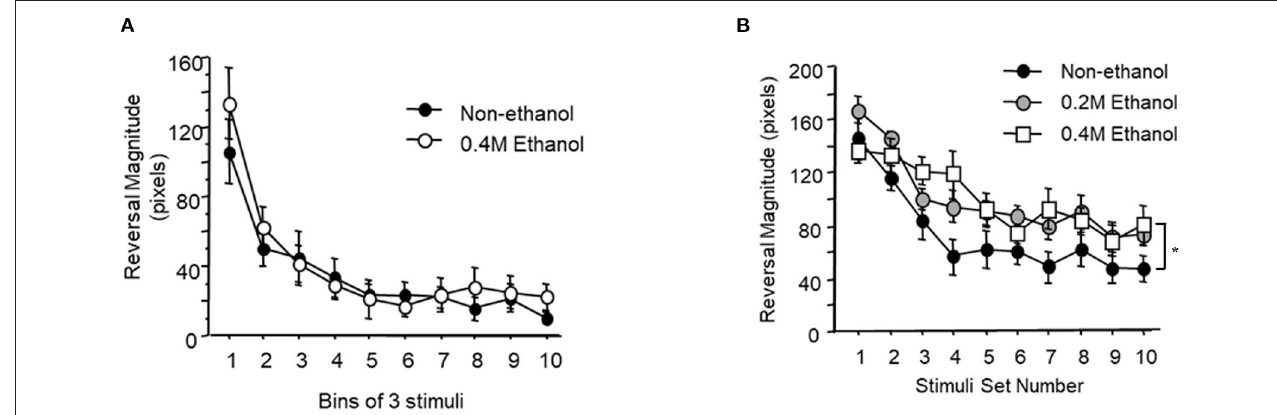
FIGURE 2 | Short-term habituation during ethanol exposure. (A) Mean reversal magnitude ( ± SEM) to 30 tap stimuli delivered at a 10s interstimulus interval and averaged in bins of three stimuli for control (black circle) vs. worms exposed to 0.4M ethanol (white circle). (B) Mean reversal magnitude ( ± SEM) to 30 tap stimuli delivered at a 60s ISI averaged in bins of three stimuli for control (black circle), 0.2M ethanol exposed worms (gray circle) and 0.4M ethanol exposed worms (white square).